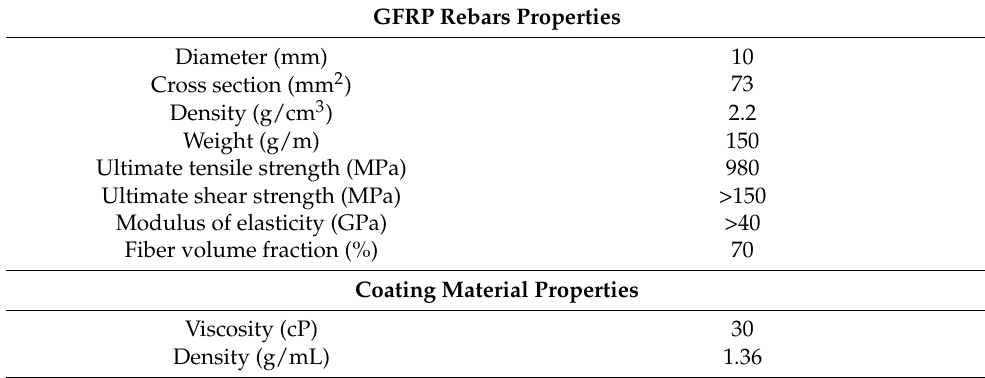
Table 1. The properties of the rebars and the coating material are as per the suppliers’ data